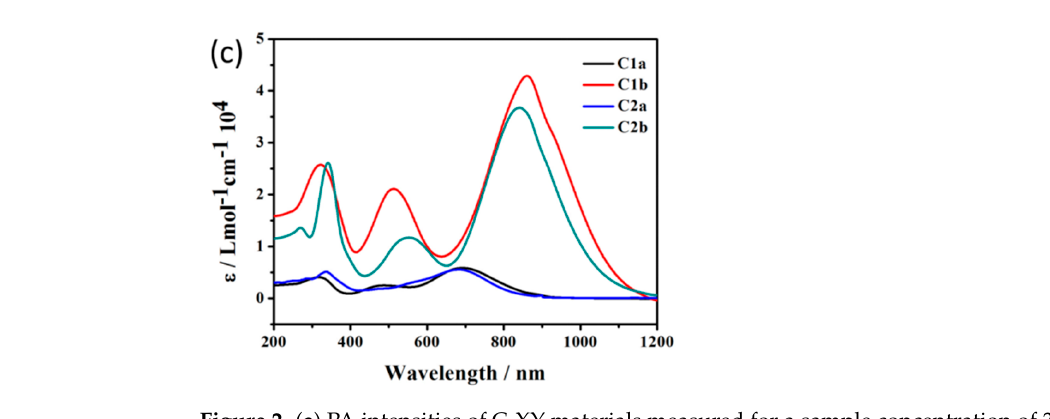
Figure 2. ( a ) PA intensities of C-XY materials measured for a sample concentration of 3 × 10 − 5 M in THF. ( b ) Heating/cooling curves of C-XY as function of time. ( c ) Molar extinction coefficients ( ε ) of C-XY measured in THF.